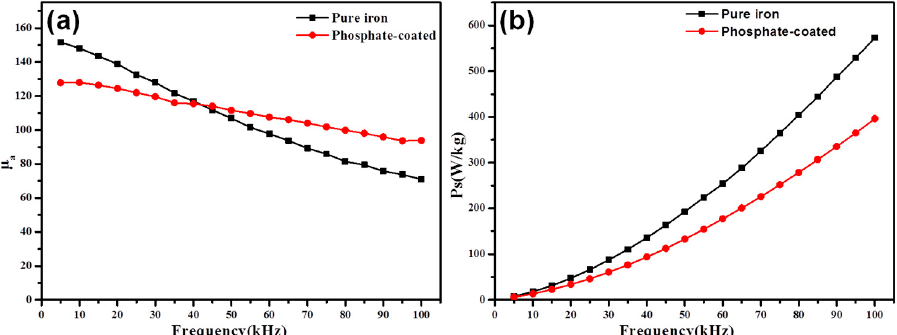
Figure 2. The effects of the phosphating process on the soft magnetic properties of the samples ( a ) the amplitude permeability and ( b ) the core loss.